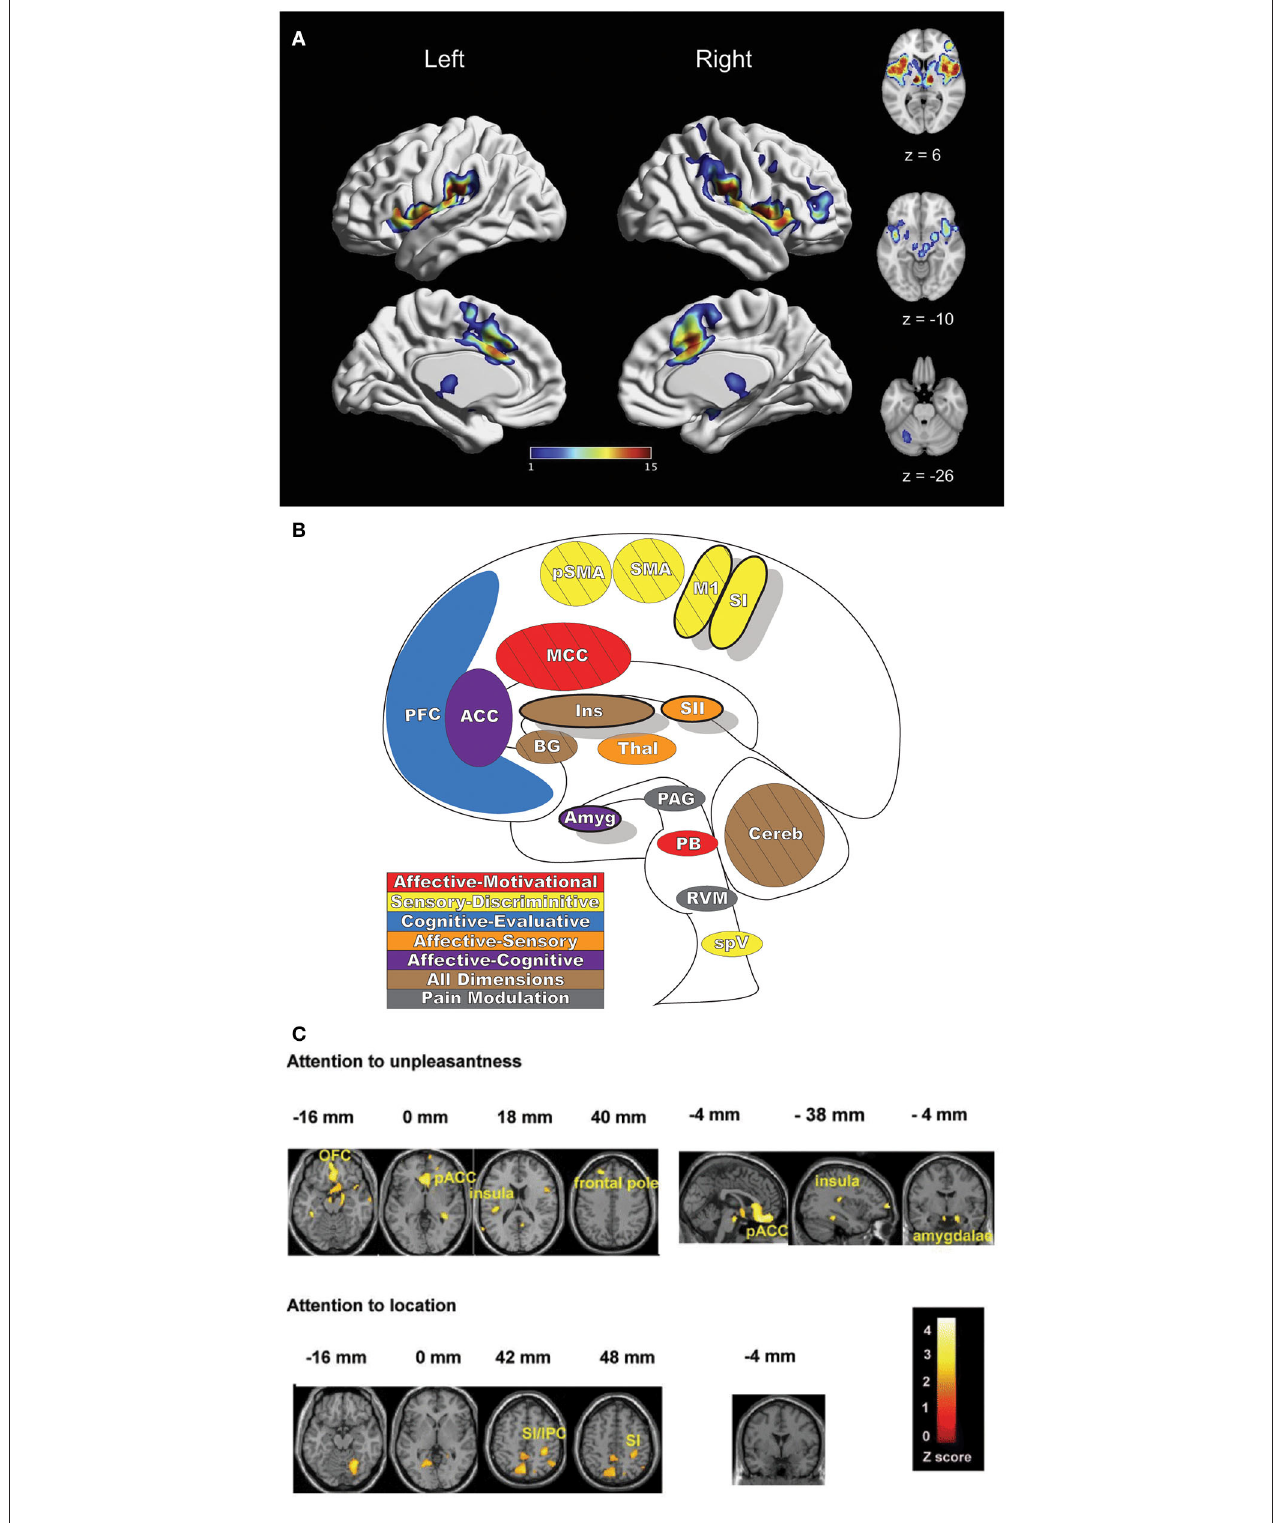
FIGURE 2 | Pain-related areas in the brain and brainstem. (A) A meta-analysis of pain neuroimaging studies defines a set of brain regions consistently active across 222 experiments from 200 reports, including bilateral activity in the secondary somatosensory cortex, insular cortex, midcingulate cortex, and thalamus. Voxel